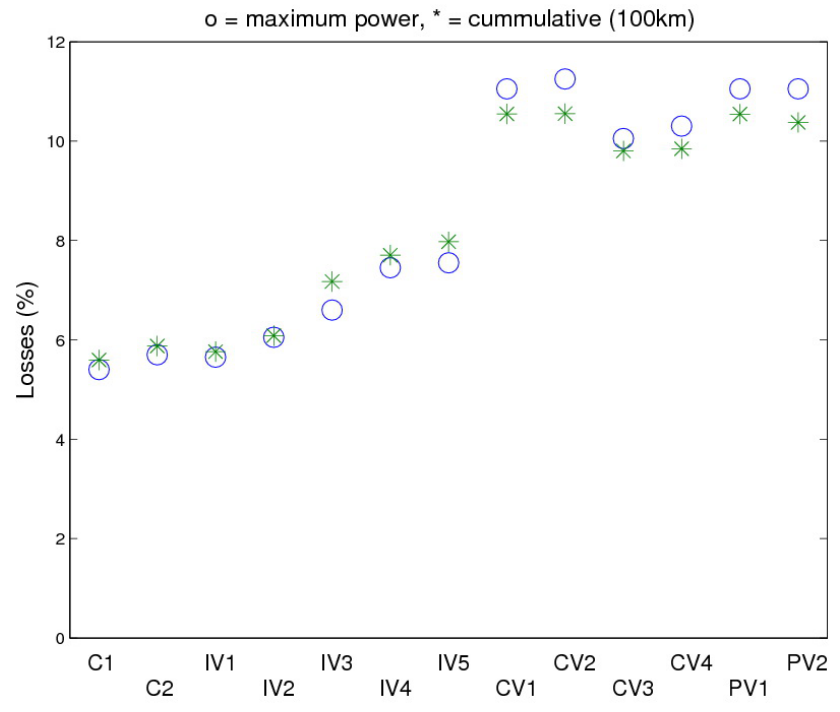
Figure 10 . Losses at maximum power and cummulative over the whole range of operation.